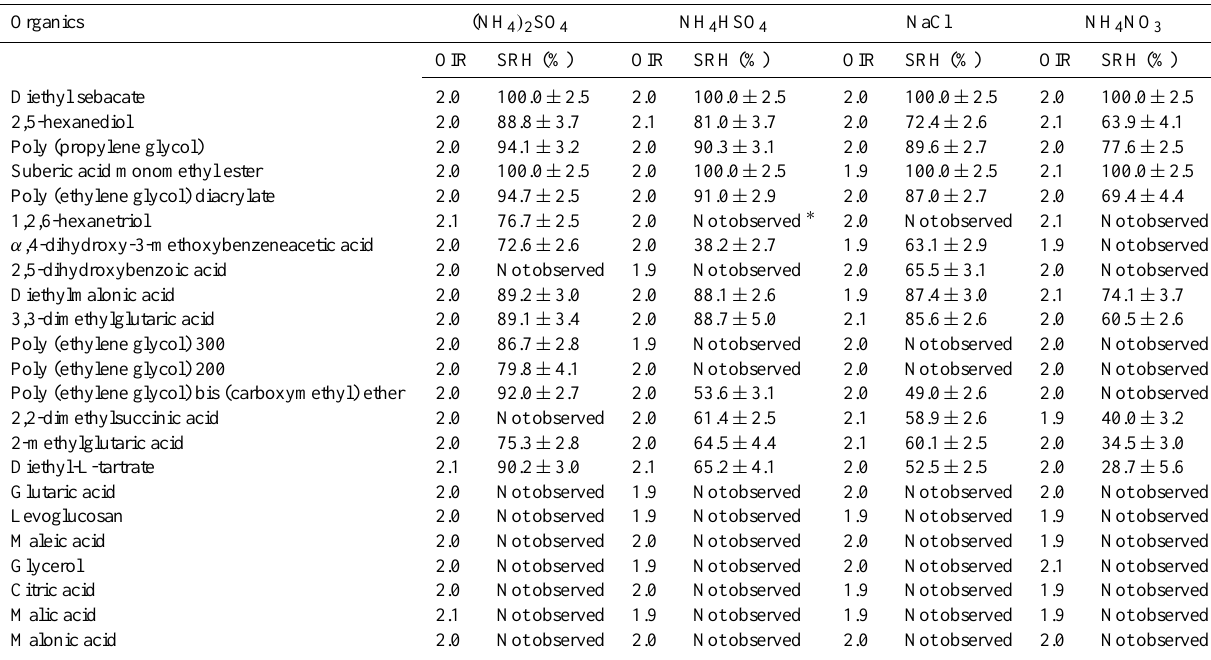
Table 2. Summary of SRH results for an organic-to-inorganic mass ratio (OIR) of 2.0 ± 0.1. Uncertainties represent 2 σ of multiple SRH measurements and the uncertainty from the